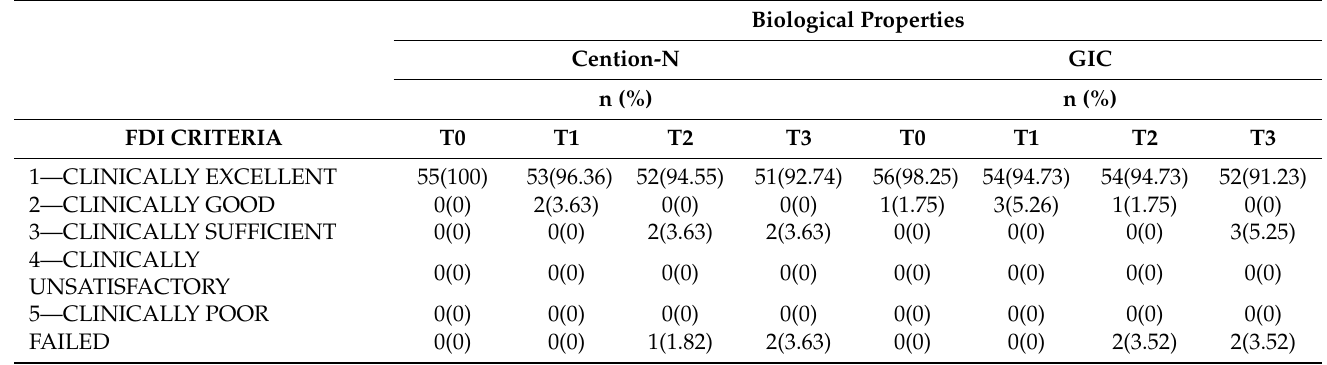
Table 5. Biological properties evaluation based on FDI criteria. T1 (3 months), T2 (6 months), T3 (12